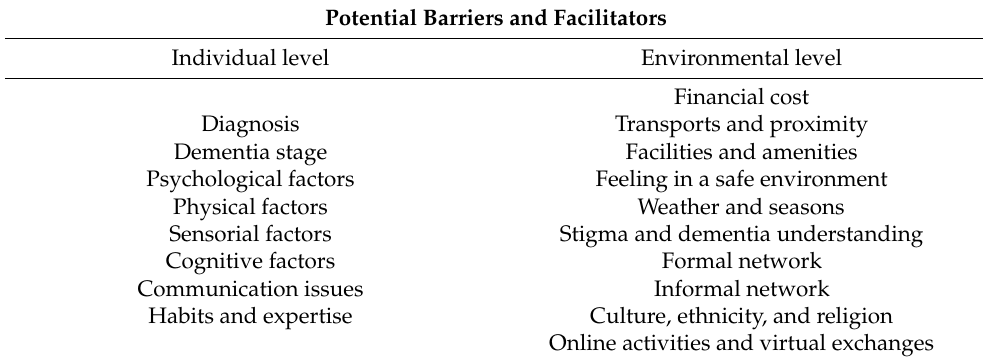
Table 5. Barriers and facilitators to taking part in